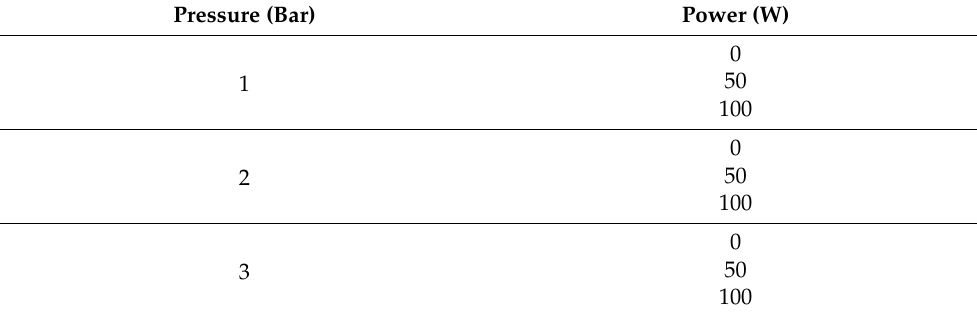
Table 1. Research